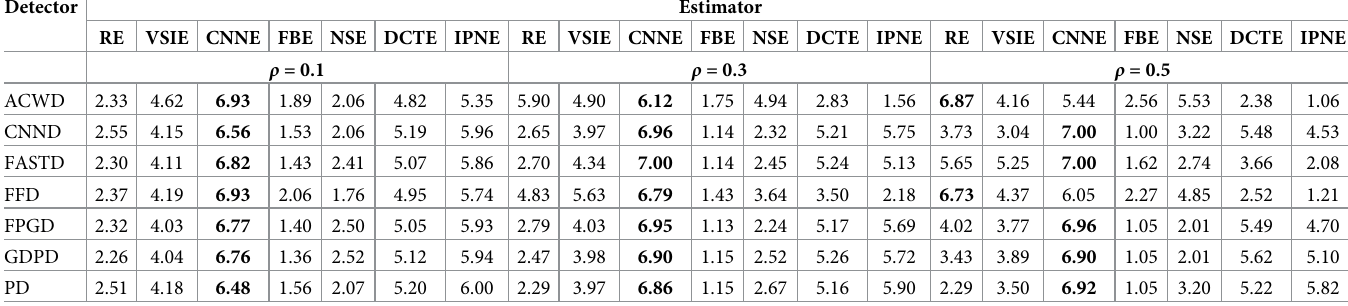
Table 5. Mean ranks from Friedman’s